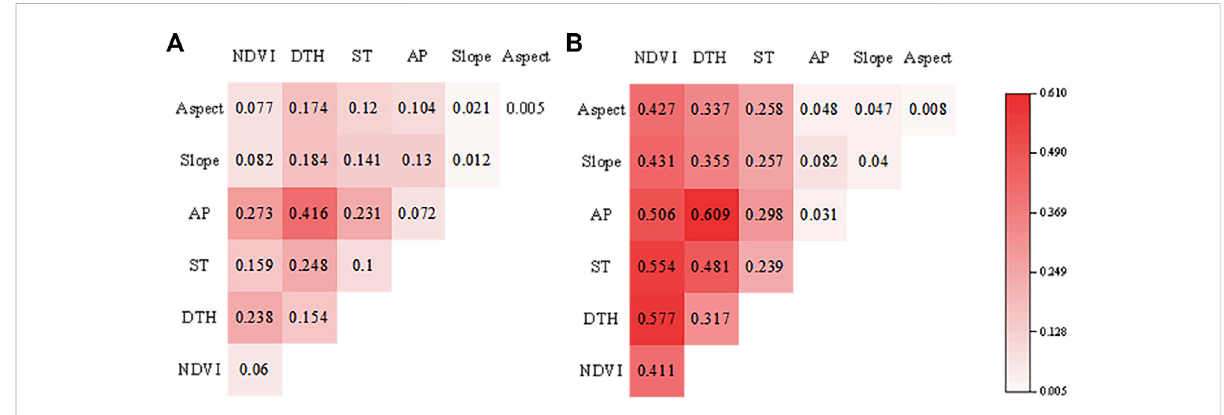
FIGURE 7 Factor interaction detection for the spatial differentiation of ESV (A) and ERI (B) . Note: DTH, distance to highway; AP, annual precipitation; ST, soil